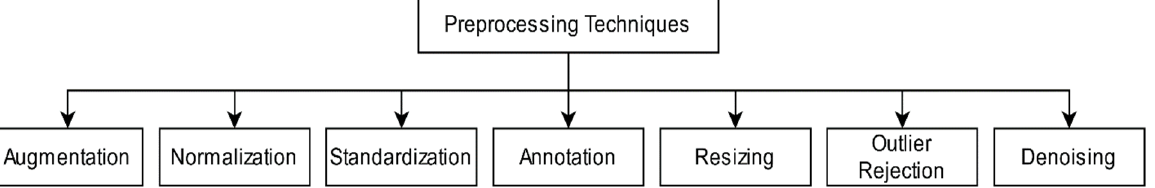
Figure 2. Categories of pre-processing techniques.